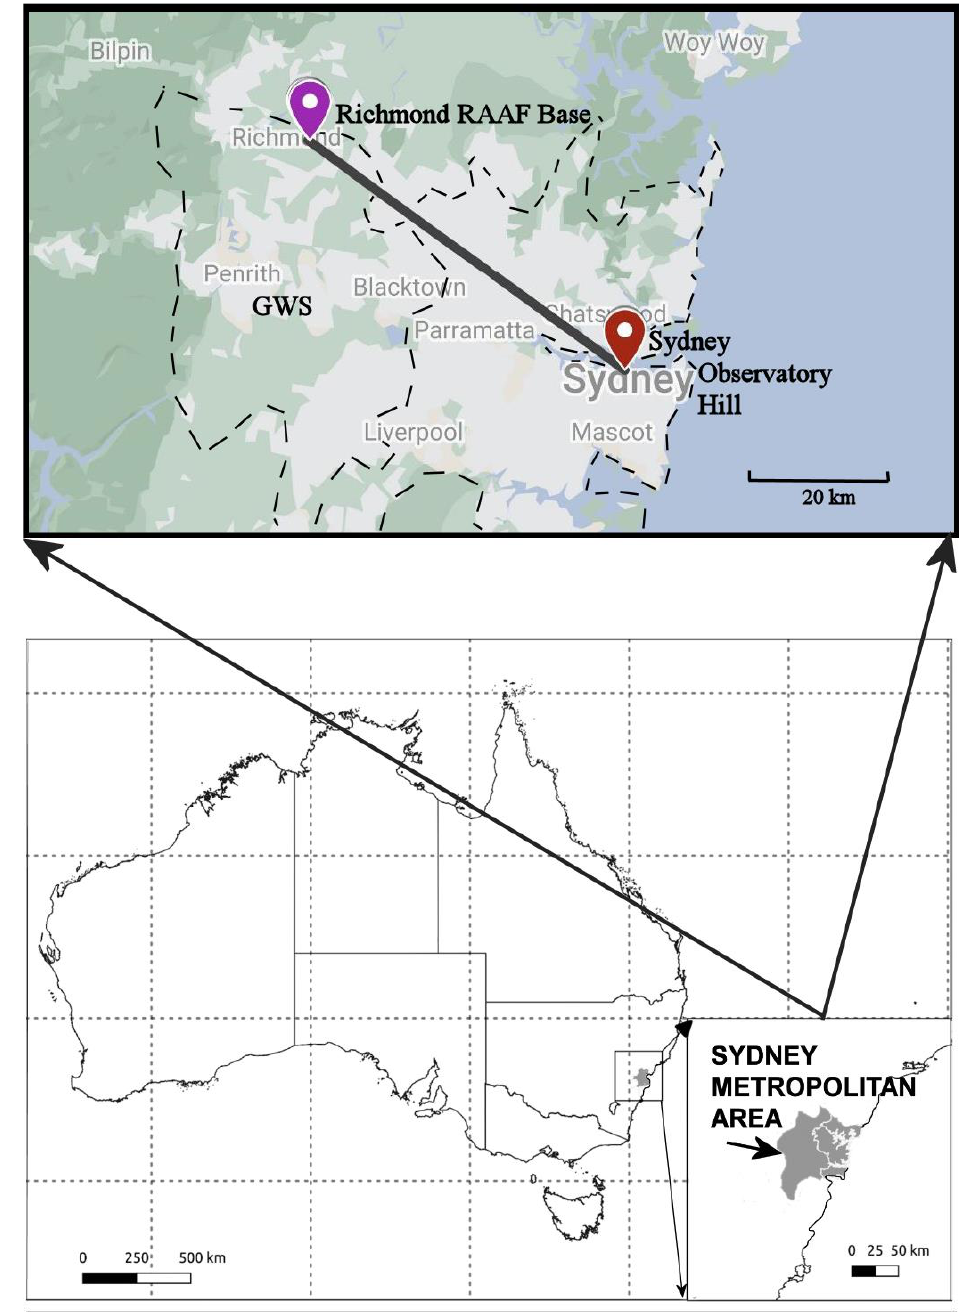
Figure 1. Map of Sydney metropolitan area enclosed by dashed lines. GWS is enclosed by the dashed lines that includes the cities of Richmond, Penrith, Blacktown, and Liverpool. Additionally marked are the two Australian Bureau of Meteorology observing sites of Observatory Hill and Richmond RAAF Base. The detailed Sydney Metropolitan area is also shown as an inset map within Australia.